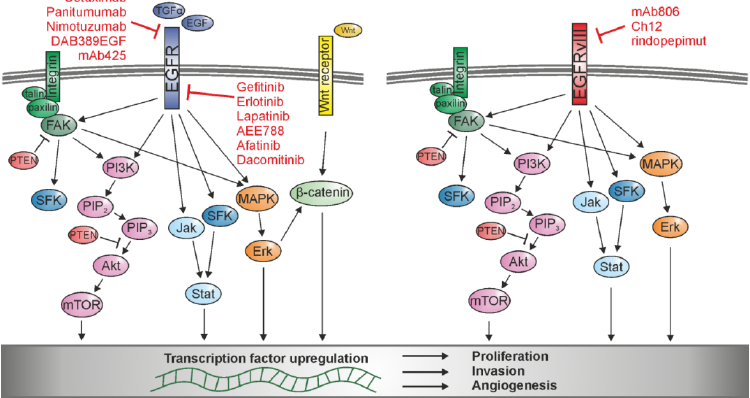
Figure 2. Schematic of signaling pathways activated by EGFR and EGFRvIII and their interaction with integrin and Wnt signaling. Activation upregulates different transcription factors involved in tumor cell proliferation, invasion, and angiogenesis, which can be blocked by various EGFR- and EGFRvIII-specific agents.